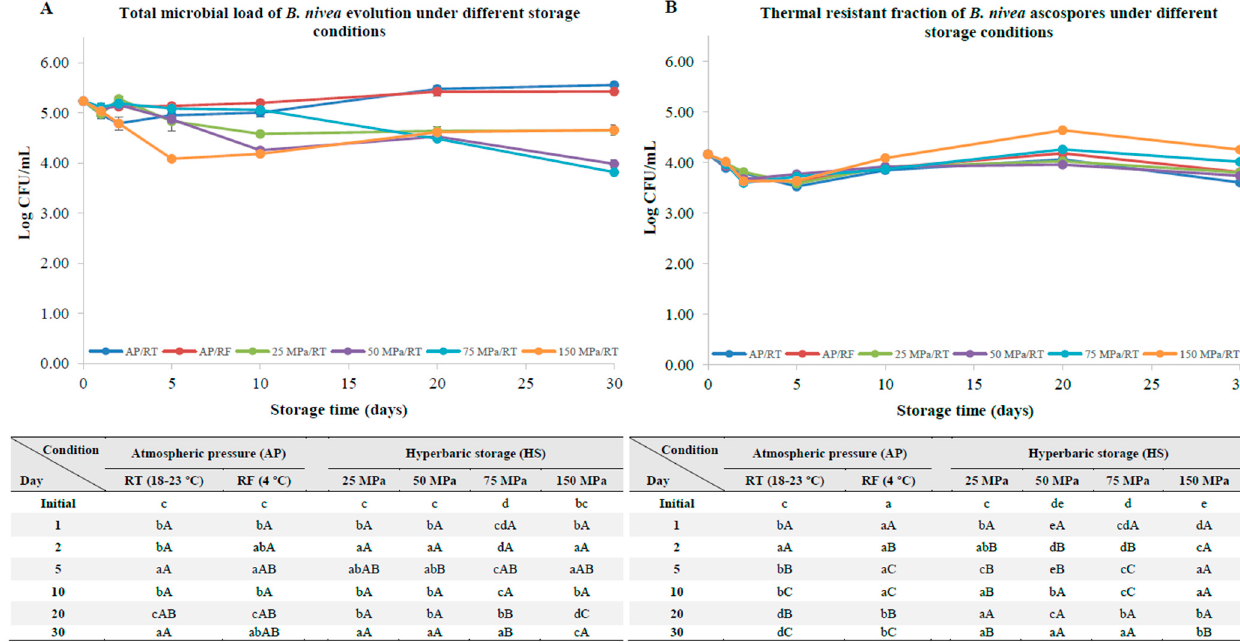
Figure 1. Total microbial load (unheated samples, ( A )) and thermal resistant ascospore fraction (heat-treated samples at 70 °C for 10 min, ( B )) of B. nivea in commercial apple juice (pH 3.7) stored at atmospheric pressure (AP) and naturally variable/uncontrolled room temperature (18–23 °C, AP/RT), AP under refrigeration (4 °C, AP/RF) and hyperbaric storage (25, 50, 75 and 150 MPa, HS) at naturally variable/uncontrolled RT, without any pre-activation step. Different lower-case letters (a–e) indicate significant differences ( p < 0.05) between storage days, while different upper-case let- ters (A–C) indicate significant differences between storage conditions (for a given day).